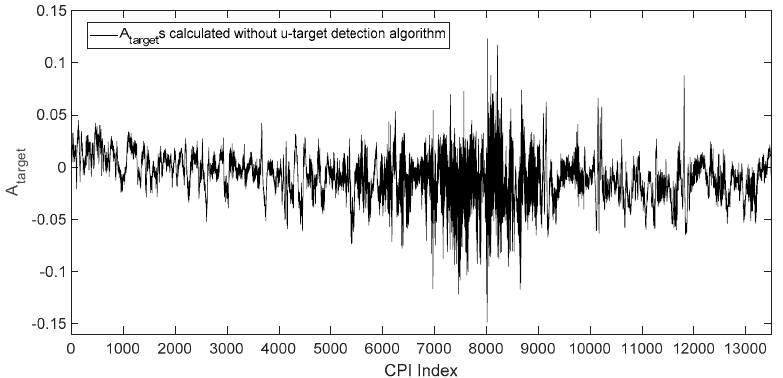
Figure 8. 𝐴 (cid:2930)(cid:2911)(cid:2928)(cid:2917)(cid:2915)(cid:2930) s calculated by all range profile samples in each coherent processing interval (CPI). Figure 8. A target s calculated by all range profile samples in each coherent processing interval